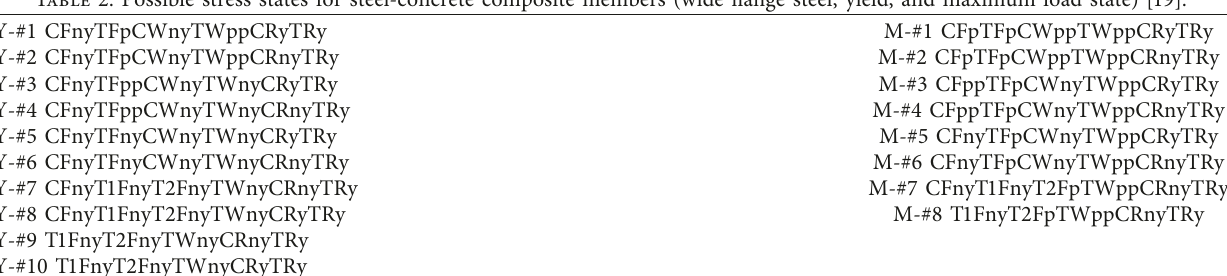
Figure 3: Possible stress states in the preyield state (S), yield limit state (Y), and maximum limit state (M) (Specimens #1, #2, and #3) [19]. Table 2: Possible stress states for steel-concrete composite members (wide flange steel, yield, and maximum load state) [19].